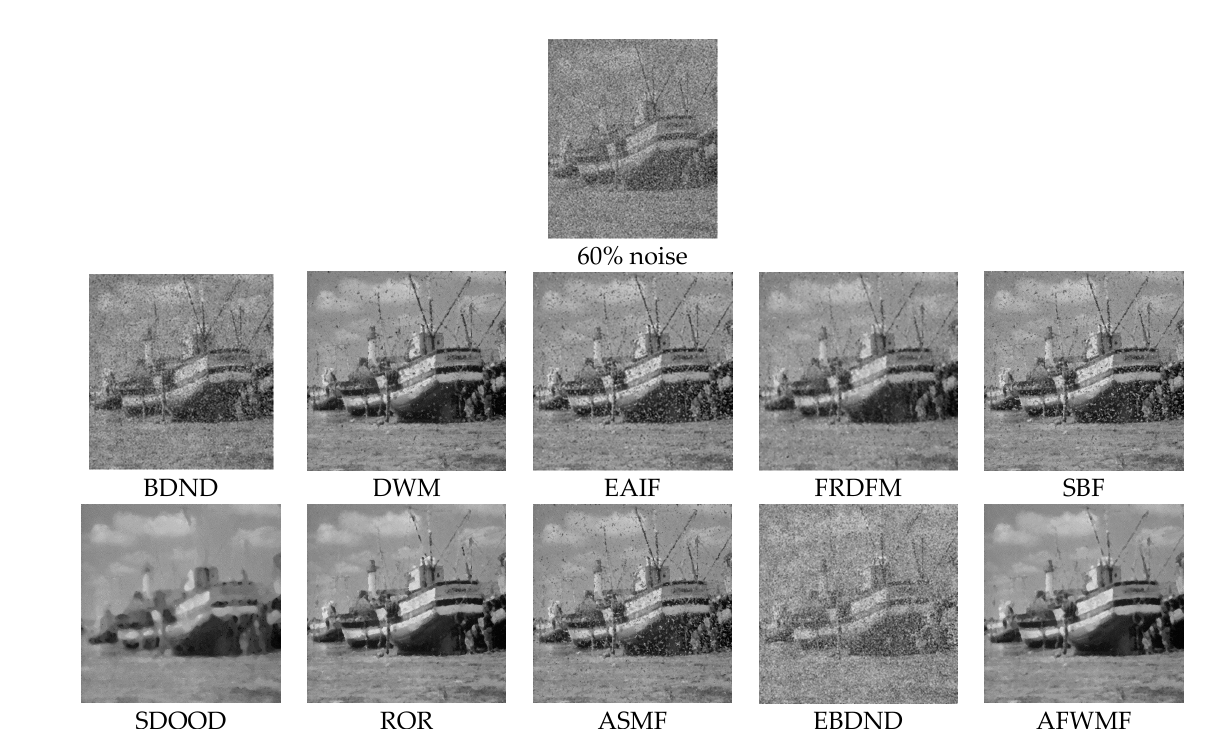
Figure 15. Repair map with a 60% random value of impulse noise for the Boat image.